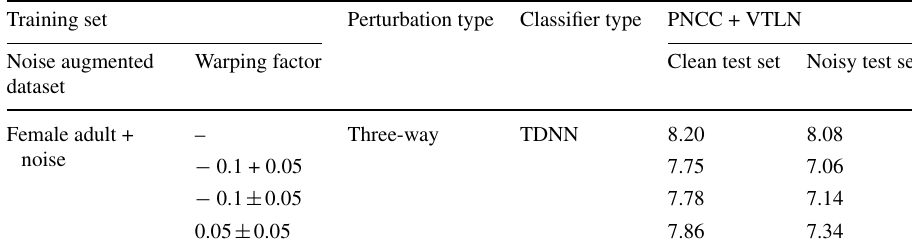
Table 11 An overview of WER obtained after combining spectral warping technique through mismatched systems on clean and noisy test